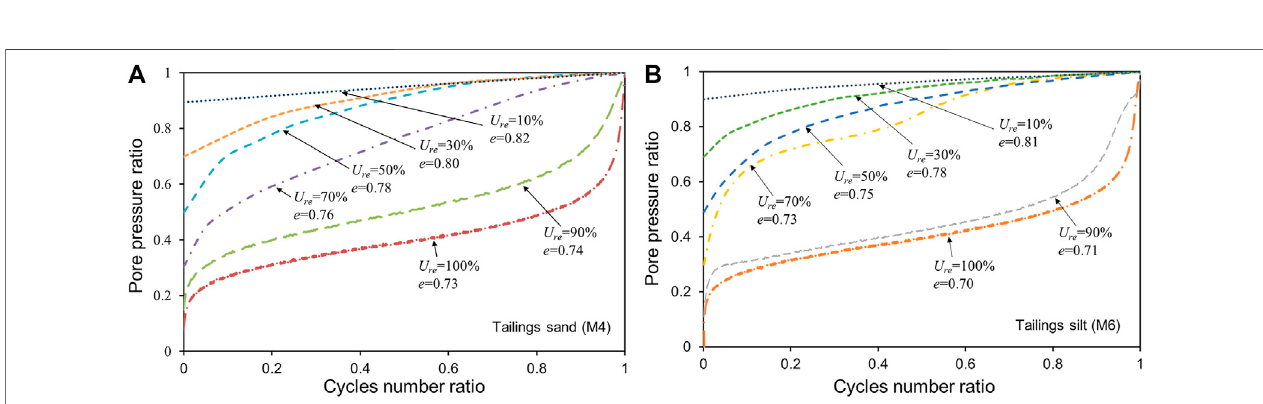
FIGURE 8 | Dynamic pore pressure models of tailings after liquefaction with different reconsolidation degrees ( U re ): (A) tailing sand (M4) and (B) tailing silt (M6).